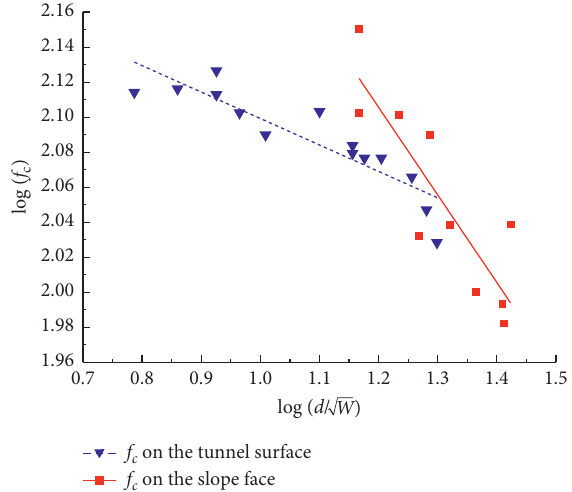
Figure 9: Center frequency versus scaled distance on the log-log plot based on the field monitoring data.